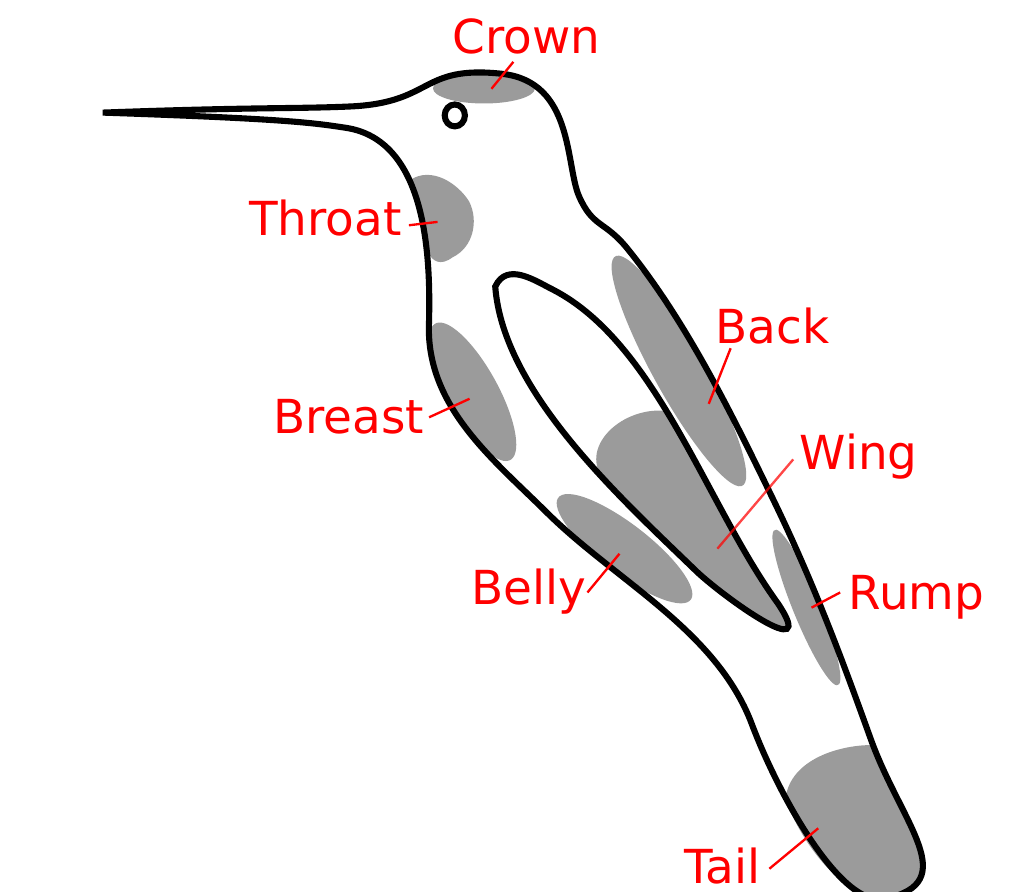
Supplementary figure 1 – Locations and names of the 8 patches measured on all species. Additional patches were measured for each species as soon as they differed from one of the 8 patches listed here for a human observer, as detailed in the methods section and as in Gomez and Théry